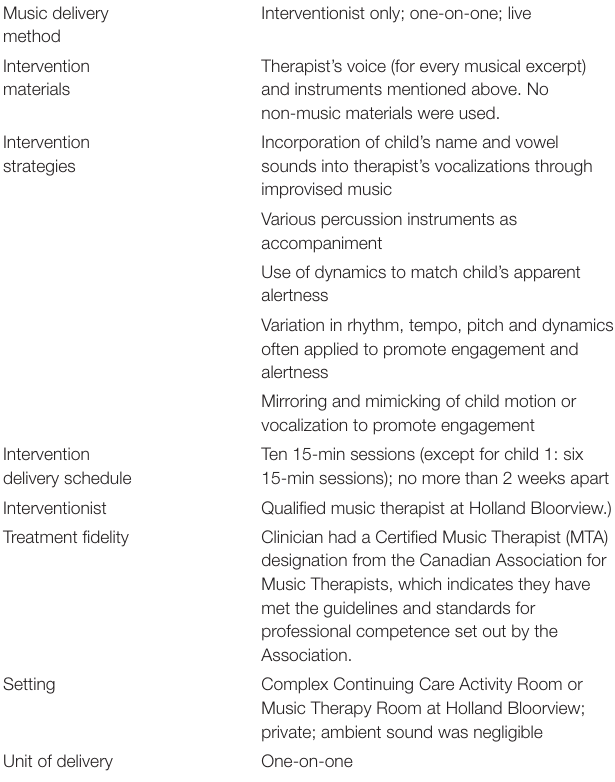
TABLE 4 | Intervention checklist. Music delivery